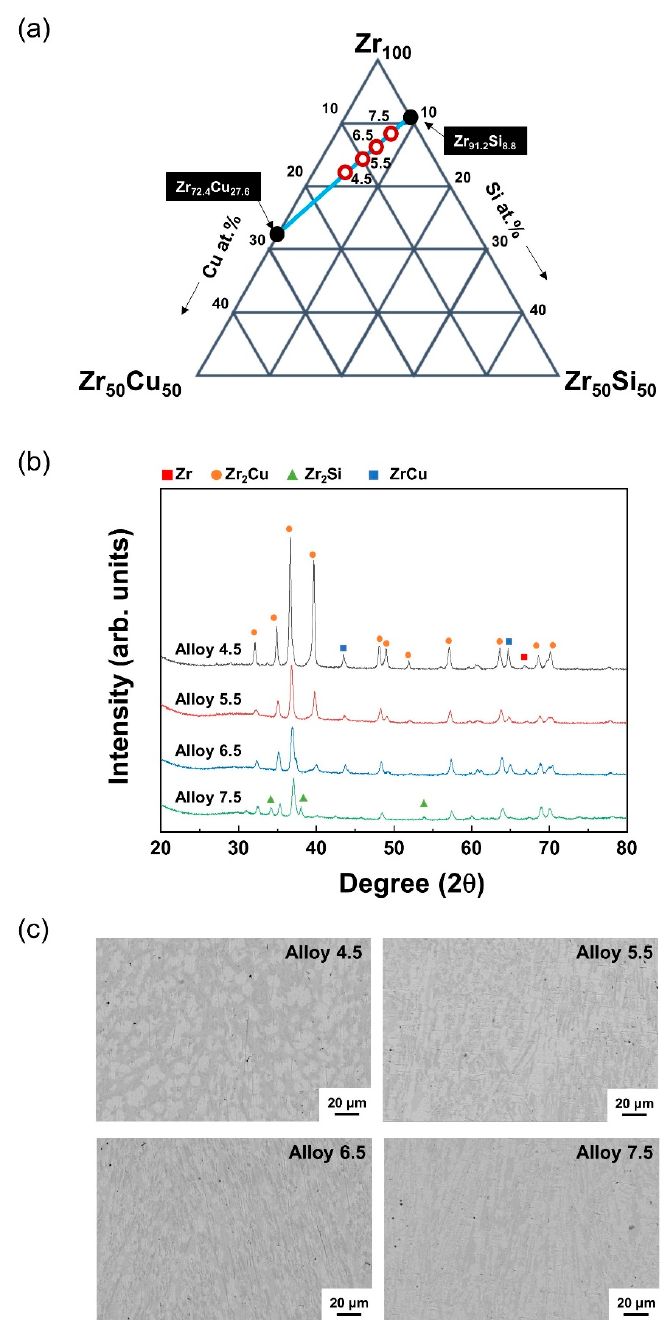
Figure 1. ( a ) Compositional design of Zr–Cu–Si target. ( b , c ) Analysis of manufactured targets prepared by arc melting. ( b ) XRD peak of ZrCuSi targets. ( c ) Surface BSE images of the prepared ZrCuSi targets.